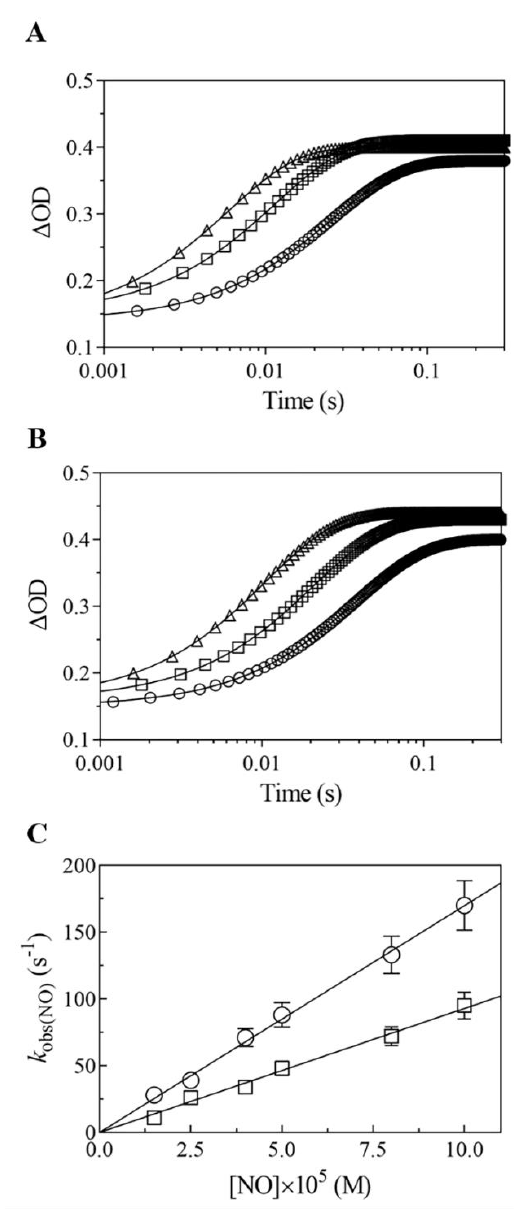
Figure 8. Kinetics of Mt -Nb(II) and Hs -Nb(II) nitrosylation by rapid-mixing stopped-flow technique, at λ = 405 nm, pH 7.0 and 22.0 ◦ C. ( A ) Time course of NO binding to Mt -Nb(II) at [NO] = 2.5 × 10 − 5 M (circles), [NO] = 5.0 × 10 − 5 M (squares), and [NO] = 1.0 × 10 − 4 M (triangles). The analysis of the time courses according to Equation (1) allowed to determine the following values of k obs(NO) : (3.9 ± 0.4) × 10 1 s −1 (circles), (8.8 ± 0.9) × 10 1 s −1 (squares), and (1.7 ± 0.2) × 10 2 s −1 (triangles). Under all the experimental conditions, the R -squared value for NO binding to Mt -Nb(II) was 0.999. ( B ) Time course of NO binding to Hs -Nb(II) at [NO] = 2.5 × 10 −5 M (circles), [NO] = 5.0 × 10 −5 M (squares), and [NO] = 1.0 × 10 −4 M (triangles). The analysis of the time courses according to Equation (1) allowed to determine the following values of k obs(NO) : (2.6 ± 0.3) × 10 1 s −1 (circles), (4.8 ± 0.5) × 10 1 s −1 (squares), and (9.5 ± 1.0) × 10 1 s −1 (triangles). Under all the experimental conditions, the R -squared value for NO binding to Hs -Nb(II) was 0.999. ( C ) Dependence of k obs(NO) for Mt -Nb(II) (circles) and Hs -Nb(II) (squares) nitrosylation on the NO concentration. The straight lines were calculated according to Eqn. 4 with the following values of k on(NO) : 1.7 × 10 6 M −1 s −1 (circles) and 9.3 × 10 5 M −1 s −1 (squares). Where not shown, the error bars are smaller than the symbols. p values for NO binding to Mt -Nb(II) and Hs -Nb(II) are <0.0001.